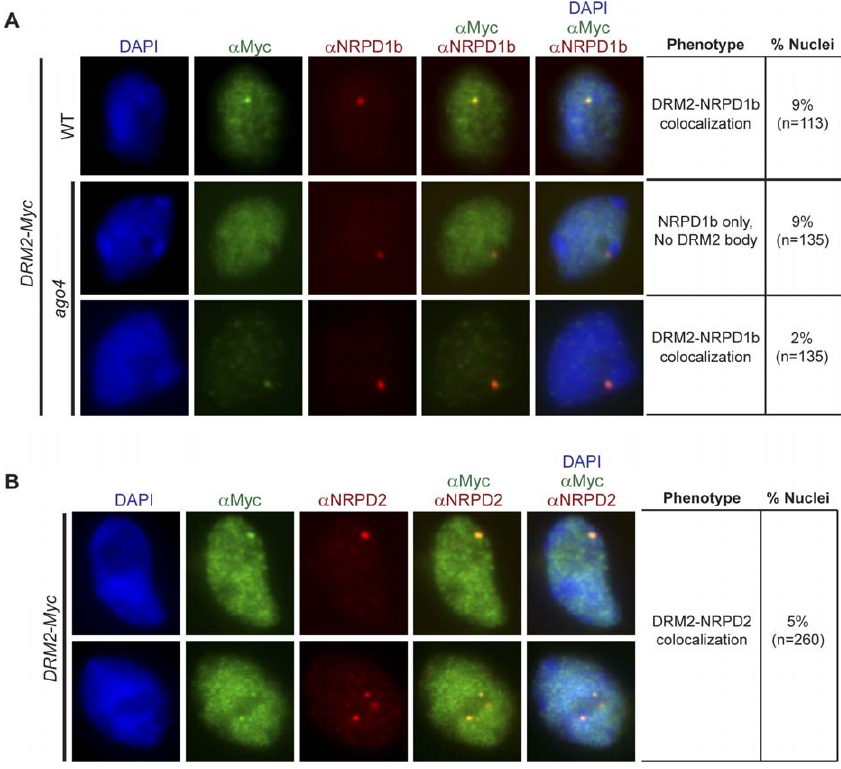
Figure 7. Localization of DRM2 with AB-odies (A) DRM2-Myc nuclear localization relative to NRPD1b in wild type or an ago4 mutant. (B) Immunofluorescence analysis of the NRPD2 nuclear body relative to the DRM2